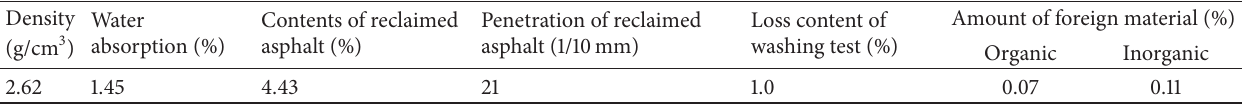
Table 1: Reclaimed asphalt pavement recycled aggregate properties.